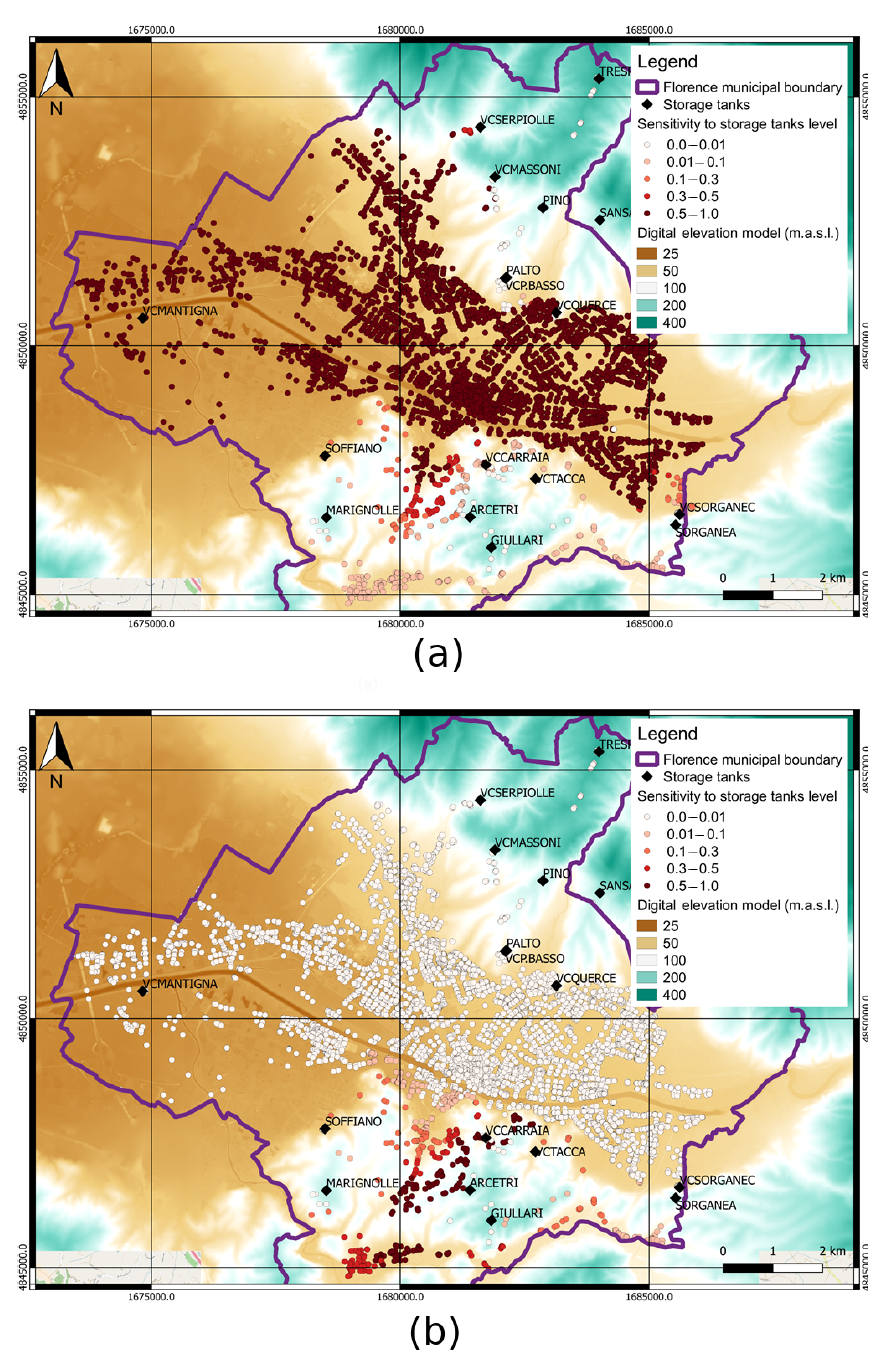
Figure 8. Digital elevation model of the study area and sensitivity to tank level for a lower tank (VCMantigna) (a) and for a upper tank (Arcetri) (b ). Reference coordinate system is